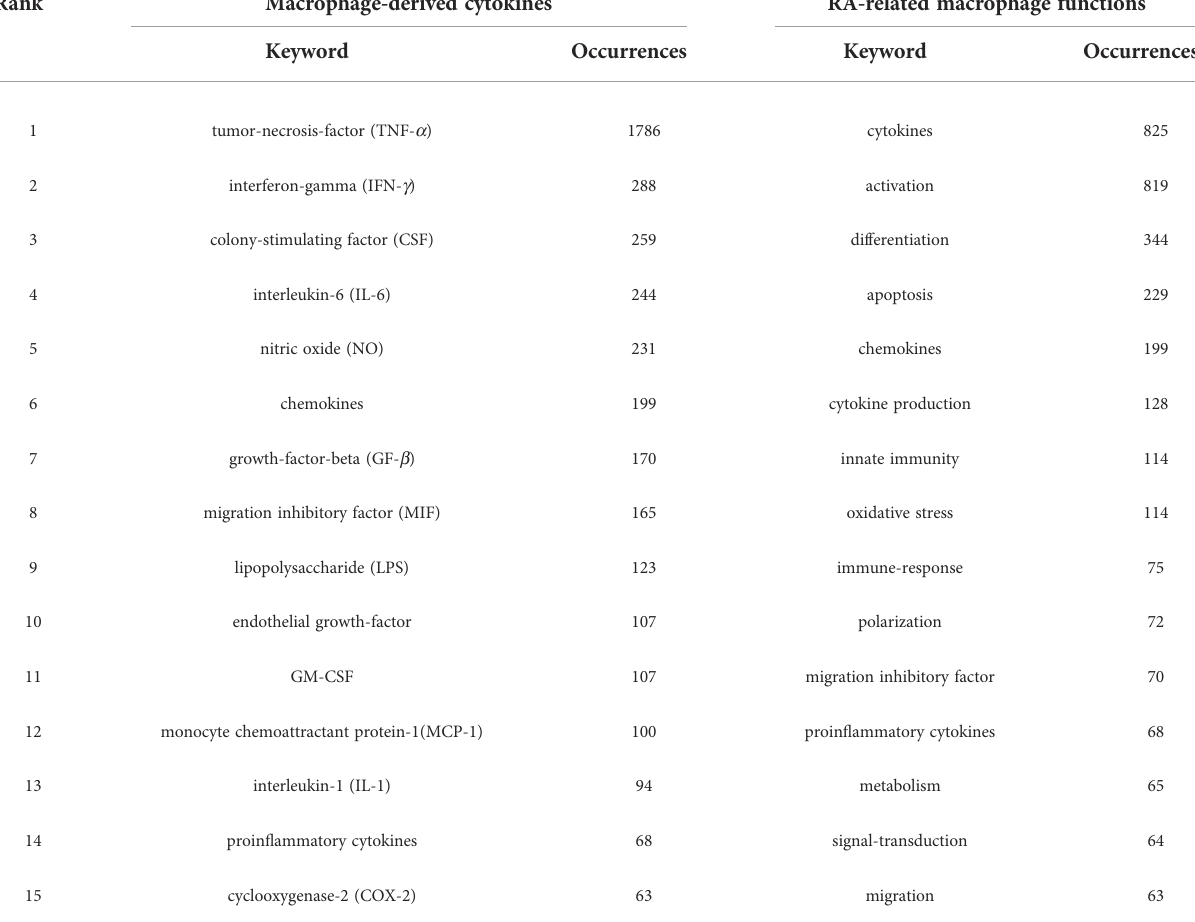
TABLE 6 Top keywords of macrophage-derived cytokines and RA-related macrophage functions (occurrences> 60).